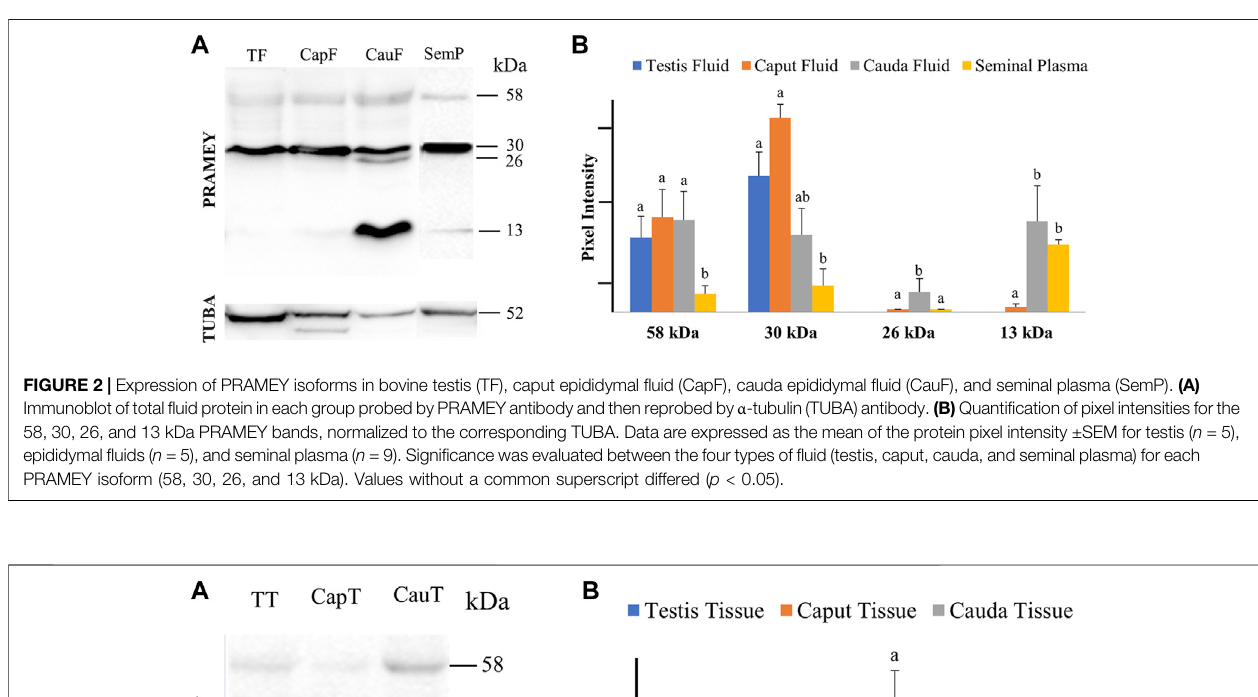
Frontiers in Genetics |